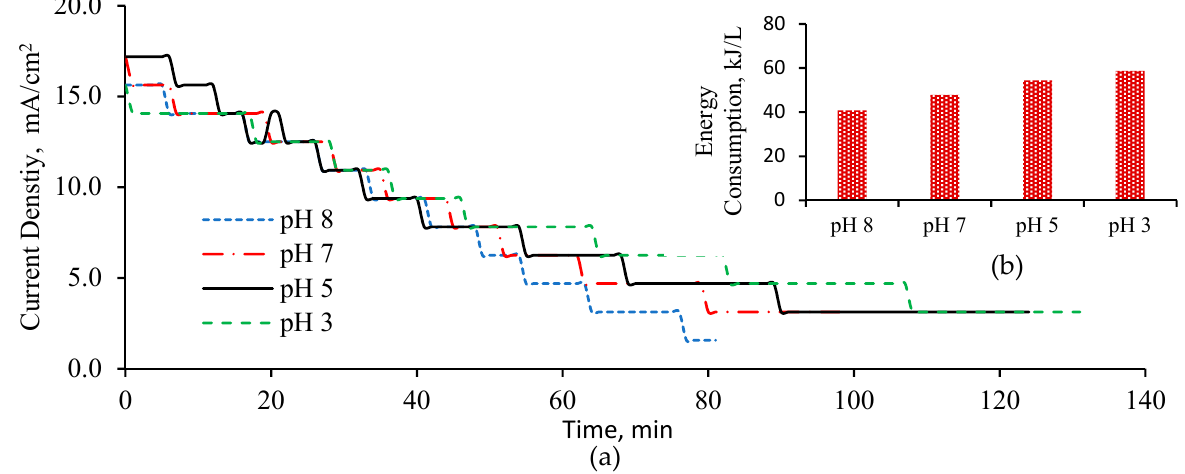
Figure 6. Current density values of BPMED system operated with different initial pH values ( a ), energy consumption for desalination of 1 L BTTWW ( b ).